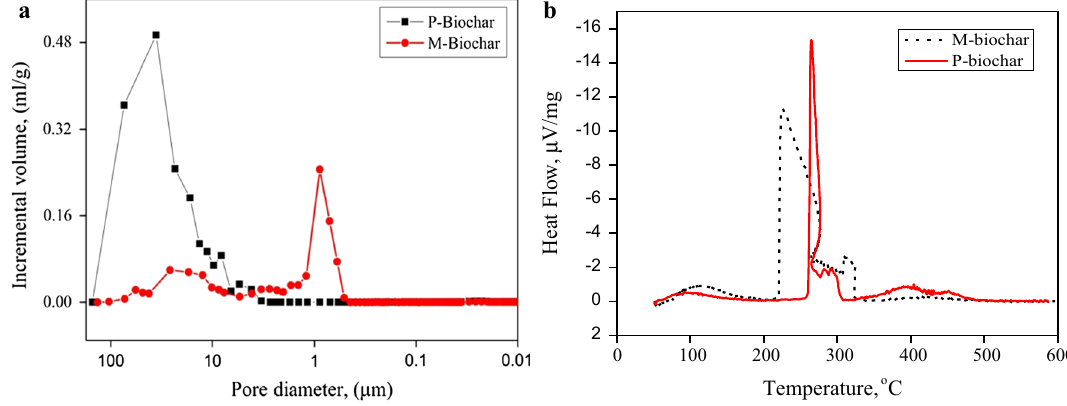
Fig. 4 a Pore size distribution and b DTA curve of p-Biochar and